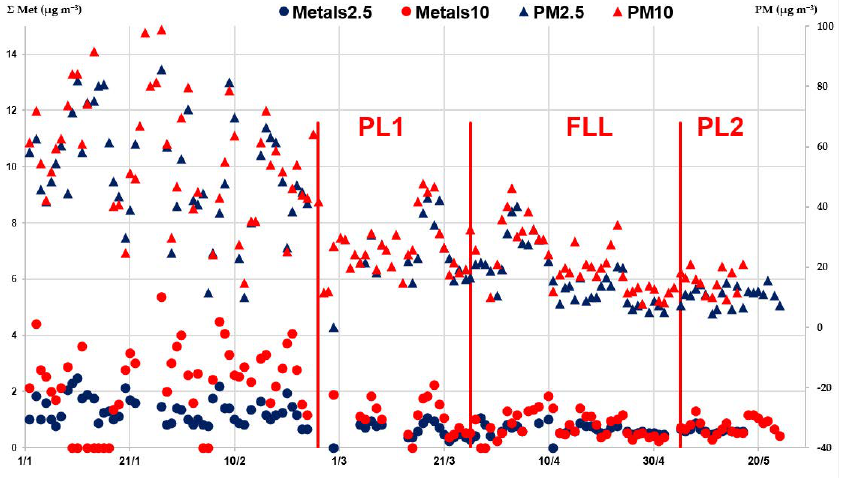
Figure 3. Temporal evolution along the whole investigated time of the total sum of the concentrations of traffic-related metals ( Σ metals) in PM 2.5 (blue points, left Y scale) and PM 10 fractions (red points, left Y scale) and PM 2.5 (blue triangles, right Y scale) and PM 10 mass concentrations (red triangles, right Y scale). The vertical lines indicate the first day of each lockdown period, namely 26 February for PL1, 25 March for FL and 5 May for PL2.